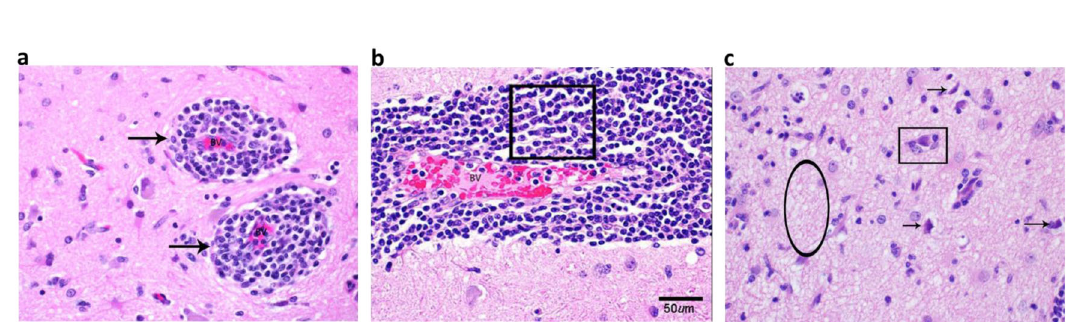
Fig. 7 Encephalitis typical of VEEV infection in nonhuman primates (NHPs). Representative pathology in the cerebrum of NHPs challenged with VEEV by aerosol. a NHP #17 (pWRG/empty vector), Cerebrum. Virchow-Robbins spaces (arrows) surrounding blood vessels (BV) in the brain. This area is moderately expanded by in fl ammatory cells. H&E 20X. b NHP #8 (pWRG/empty vector), Cerebrum. Virchow-Robbin space is moderately expanded by lymphocytes and macrophages (boxed area), or nonsuppurative in fl ammation. This is a key feature in differentiating VEEV from Eastern and Western equine encephalitis viruses (EEEV and WEEV, respectively). H&E 20X. c NHP #18 (IM-DSJI), Cerebrum. There are degenerating and dead neurons (arrows) characterized by shrunken cells that are angular and hypereosinophilic (dark red/pink)